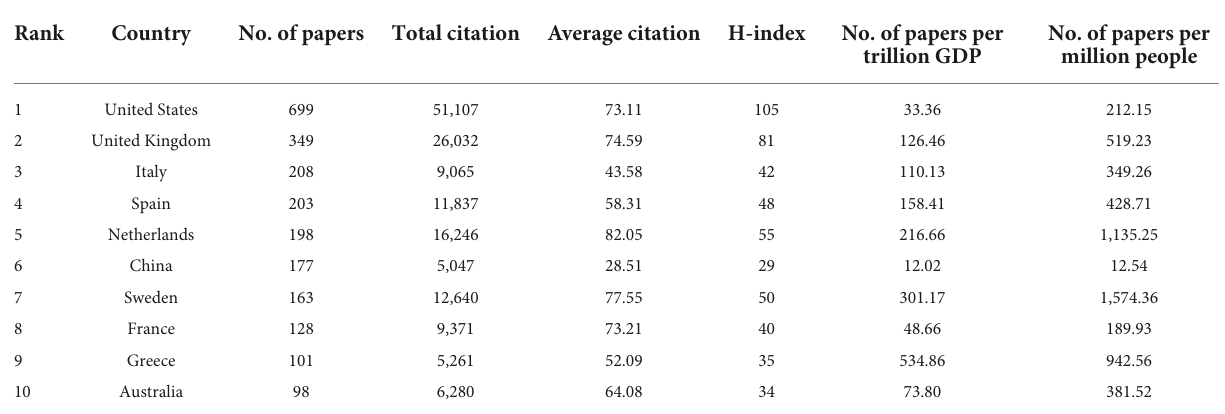
TABLE 1 Top 10 countries with the most